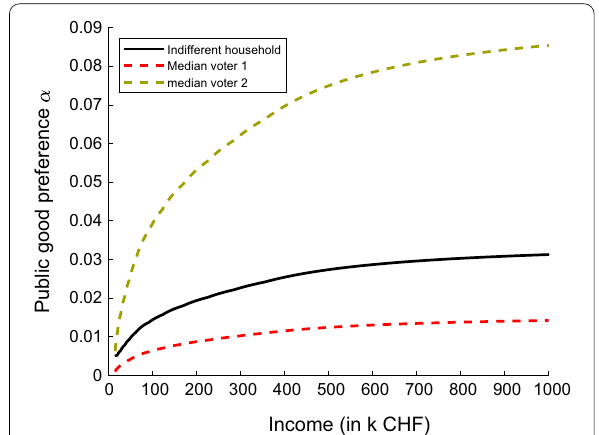
Fig. 1 Locus of indifferent households and loci of median voters in the y - α